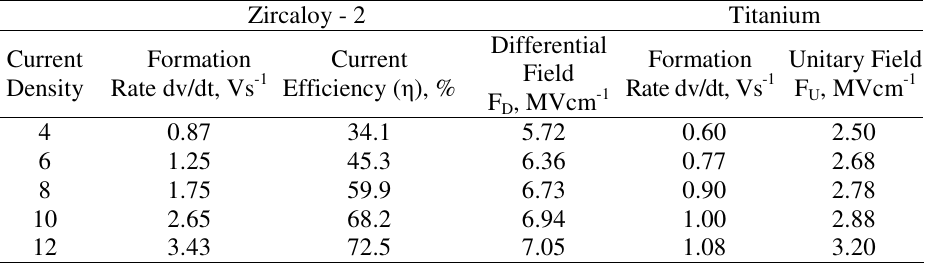
Table 4. Data on the anodisation of Zr-2 and Ti in 0.1 M sodium succinate.